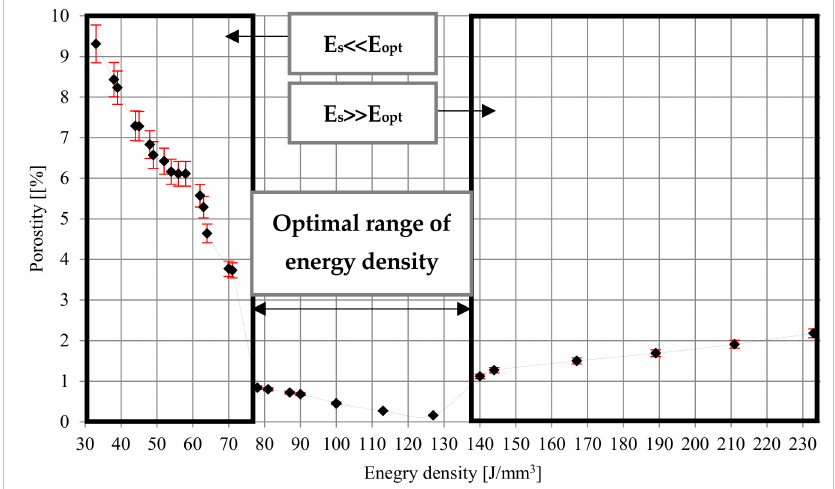
Figure 4. Relation of porosity and energy density for Ti6Al4V DMLS